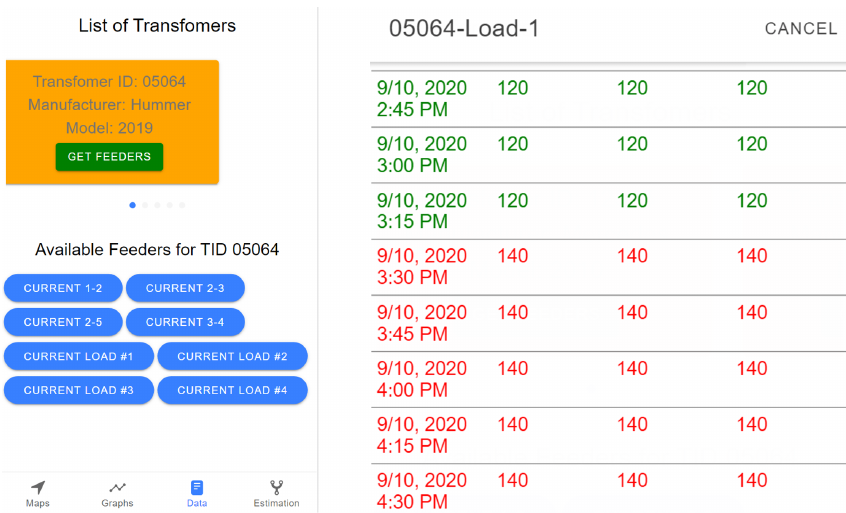
Figure 5. List of transformers and feeder current values on mobile application (green: normal, red: anomaly).